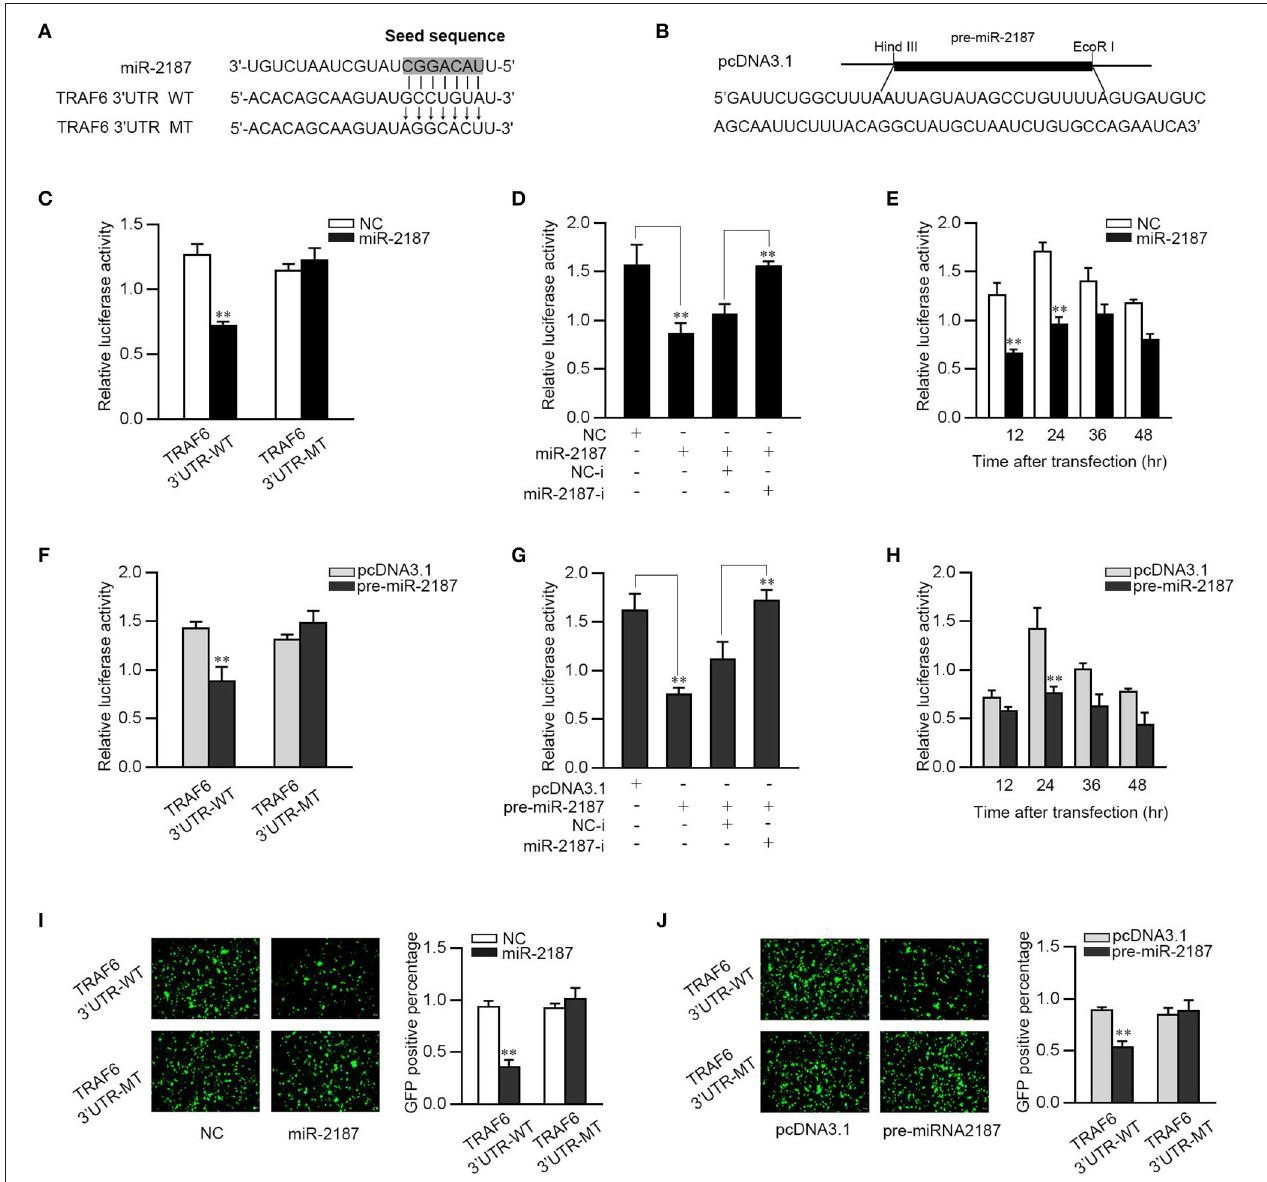
FIGURE 3 | miR-2187 targets miiuy croaker TRAF6 gene. (A) Sequence alignment of miR-2187 and its binding site in the 3 ′ -UTR of TRAF6. (B) The pre-miR-2187 sequence and the construction of the plasmid. (C) EPC cells were transfected with NC or miR-2187 along with wild-type TRAF6-3 ′ UTR (TRAF6-3 ′ UTR-WT) or the mutant type of TRAF6 3 ′ -UTR (TRAF6 3 ′ UTR-MT) for 24h, the luciferase activity was evaluated. (D) EPC cells were co-transfected with TRAF6 3 ′ -UTR-WT, together with NC, miR-2187, NC-i or miR-2187-i 24h. For each transfection, the total amount of oligonucleotides was controlled and normalized. (E) The time gradient experiments were conducted for miR-2187 transfection. (F) EPC cells were transfected with pcDNA3.1 or pre-miR-2187 along with TRAF6-3 ′ UTR-WT or the TRAF6 3 ′ -UTR-MT. (G) EPC cells were co-transfected with TRAF6 3 ′ -UTR-WT, together with pcDNA3.1, pre-miR-2187, NC-i or miR-2187-i for 24h. (H) The time gradient experiments were conducted for pre-miR-2187 transfection. The wild type or mutant type of TRAF6 3 ′ -UTR was cloned into mVenus-C1 vector. EPC cells were co-transfected with the wild type or mutant type of mVenus-TRAF6 3 ′ -UTR, together with NC or miR-2187 (I) and pcDNA3.1 or pre-miR-2187 (J) . At 48 h post-transfection, the fluorescence intensity was measured by enzyme-labeled instrument. Scale bar, 20 µ m; original magnification × 10. All the luciferase activity was normalized to Renilla luciferase activity. All data are presented as the means ± SE from at least three independent triplicated experiments. ** p < 0.01 vs. the controls.